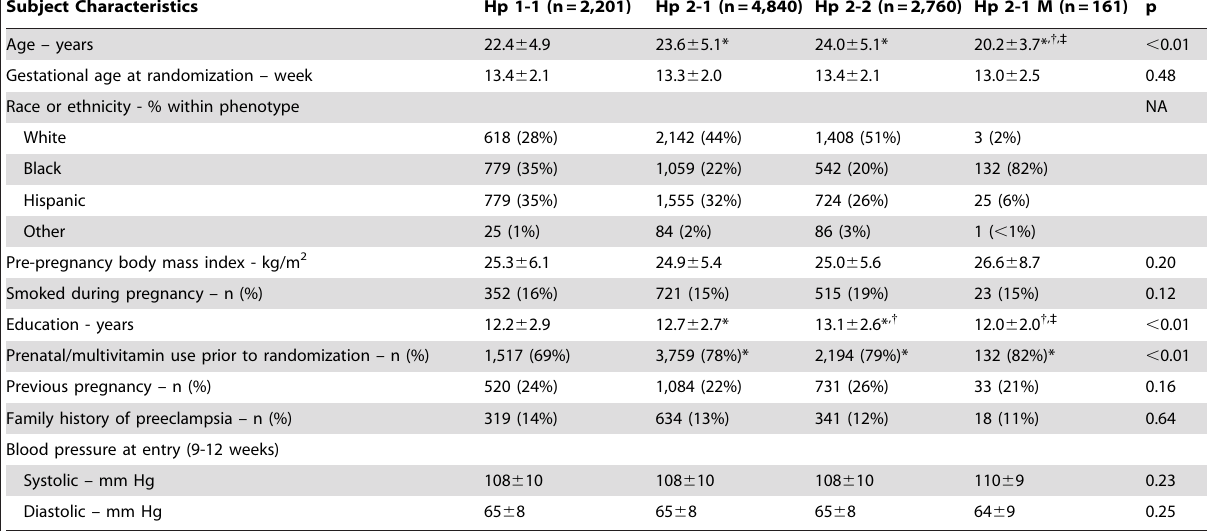
Table 1. Subject Characteristics for the Weighted Pooled Cohort by Hp phenotype.